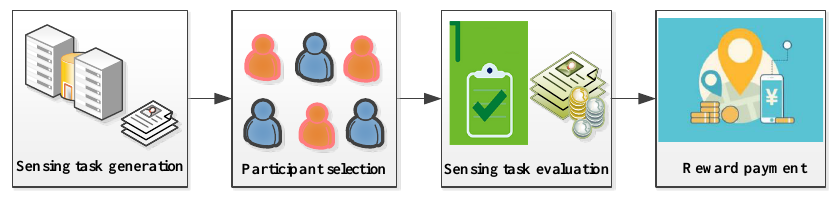
Figure 2. The incentive process of mobile crowd sensing (MCS).